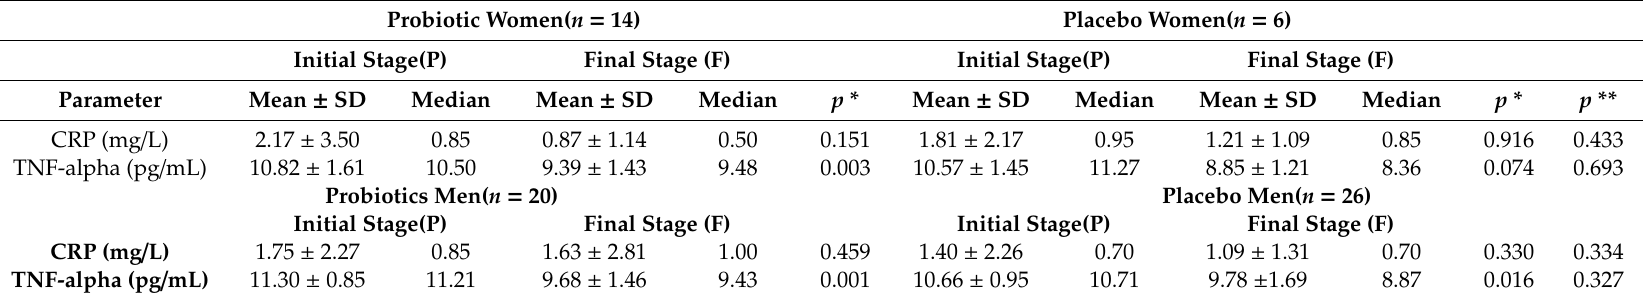
Table 5. Alterations in C-reactive protein (CRP) and tumour necrosis factor (TNF)-alpha concentrations in men and women from the probiotic and placebo groups between the initial and final stages of